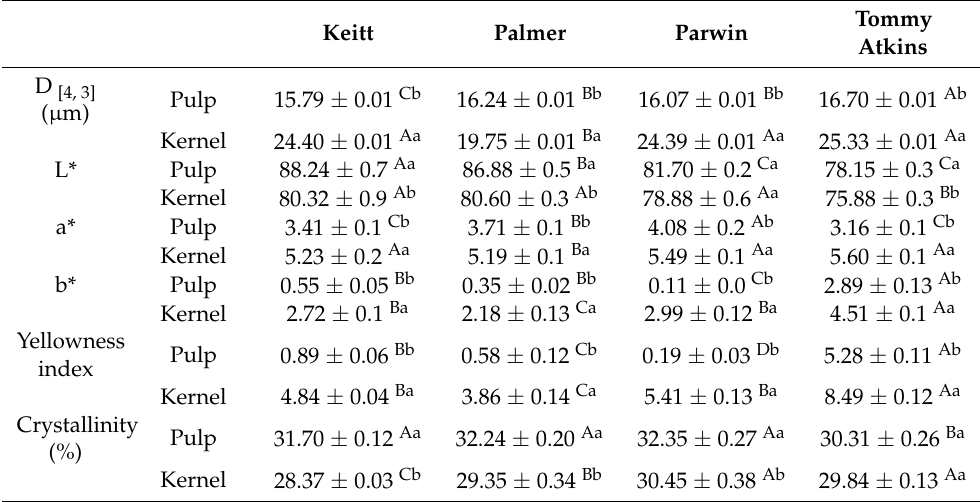
Table 2. Granule size, color and crystallinity of mango